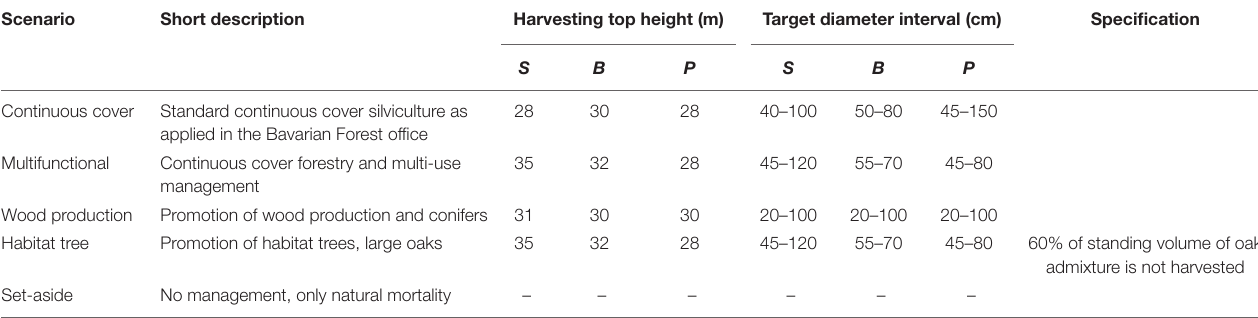
TABLE 3 | Forest management scenarios considered for forecasting the bird occurrence